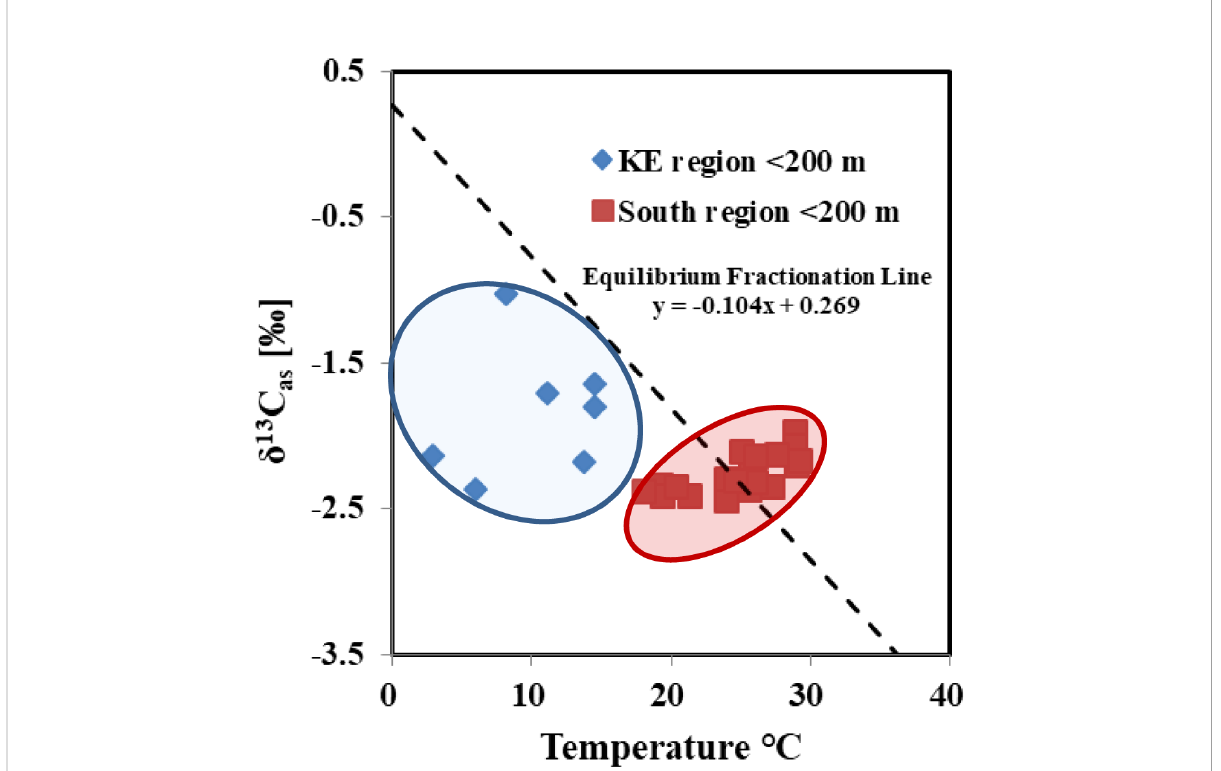
FIGURE 5 The d 13 C as versus temperature diagrams for water upper 200 m at subtropical gyre water Sea Water and Kuroshio-Oyashio Mixed Water Region. The dashed line is the equilibrium fractionation line when ocean DIC is in complete isotopic equilibrium with the atmosphere (Itou et al.,